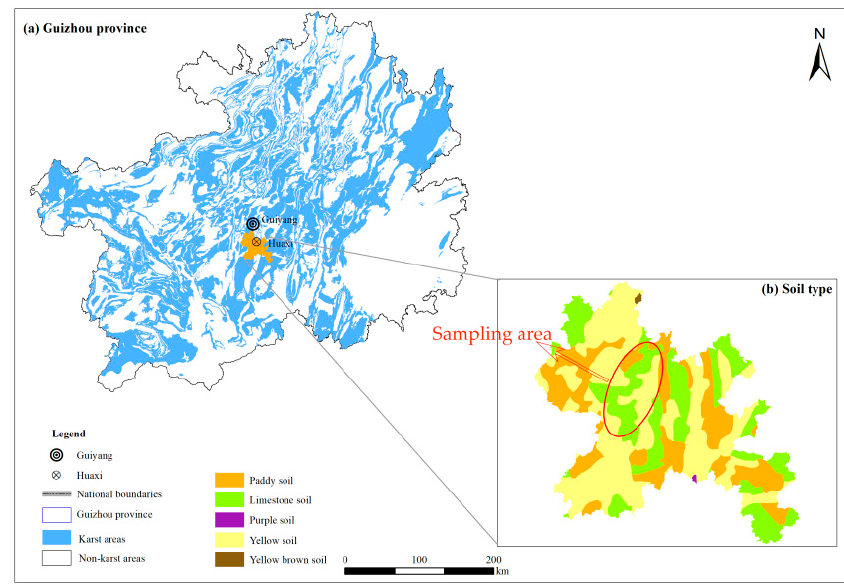
Figure 1. The location and soil types of the study area.